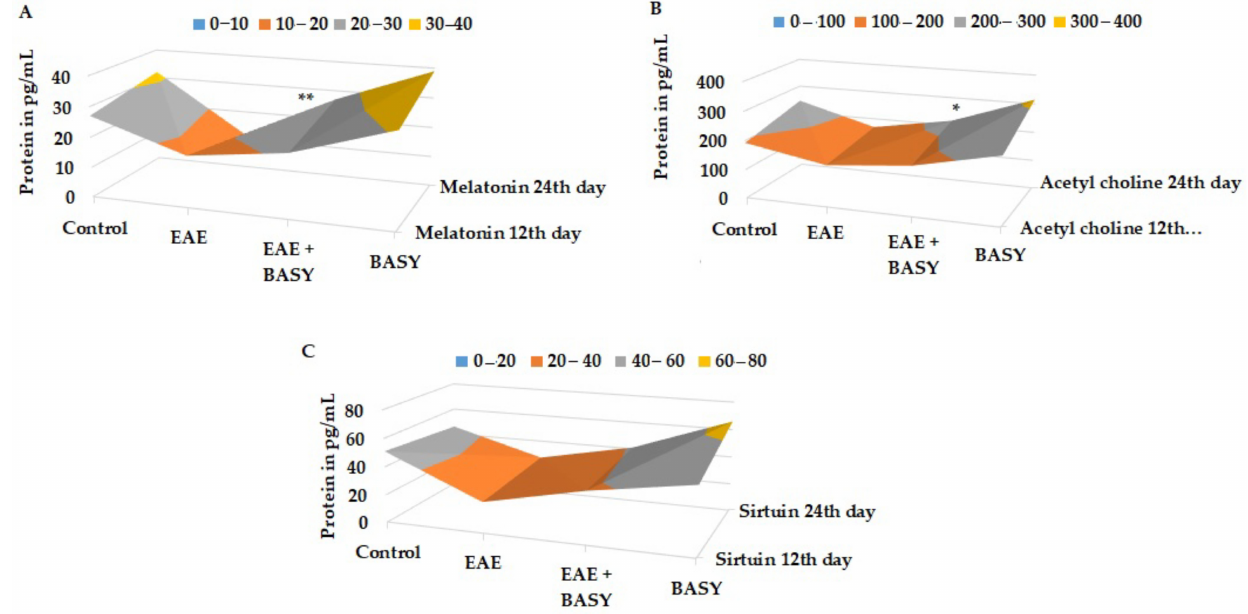
Figure 5. BASY augmented the level of neurotransmitters and neuronal hormones in MOG-immunized mice spinal tissues. ( A ) The peripheral crude lymphocytes were isolated, and total protein was